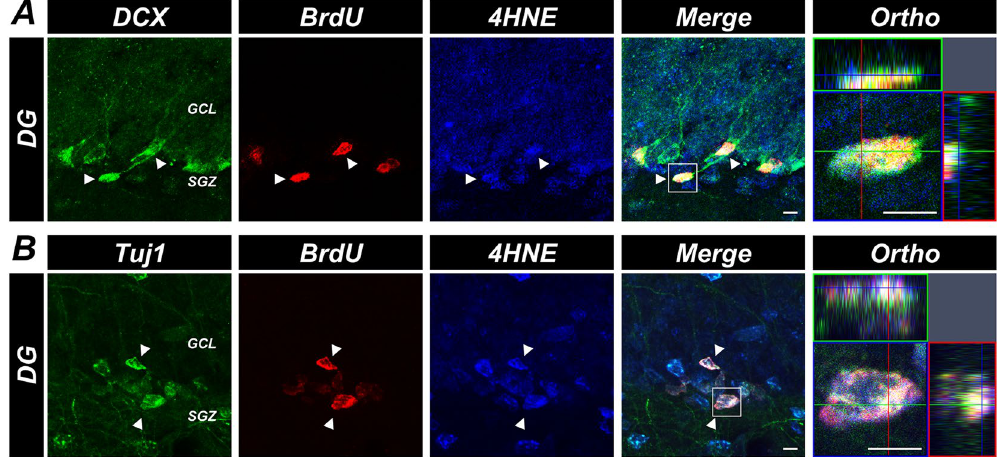
Figure 6. Newly generated neurons are exposed to oxidative stress. ( A ) Representative immunofluorescence images reveal DCX (green), BrdU (red), and 4HNE (blue) immunoreactive (DCX + /BrdU + /4HNE + , arrows) cells in the SGZ/GCL. Scale bar = 10 μ m. ( B ) Representative immunofluorescence images show Tuj1 (green), BrdU (red) and 4HNE (blue) immunoreactive (Tuj1 + /BrdU + /4HNE + , arrows) cells in the SGZ/GCL. Scale bar = 10 μ m.